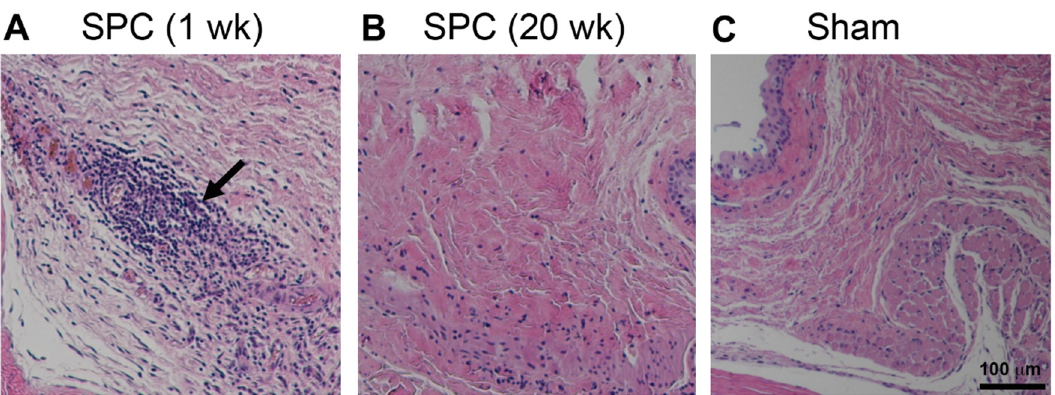
Figure 3. SPC microcrystals were well-tolerated in the subconjunctival space in rats. Either SPC microcrystals (200 μ g in 5 μ L) or vehicle (Sham) were injected unilaterally ( n = 3). Representative hematoxylin and eosin-stained images of conjunctiva tissue sections showed ( A ) mild accumulation of inflammatory cells at the injection site at 1 week after SPC microcrystal injection, which ( B ) was largely resolved before 20 weeks, similar to ( C ) vehicle injection at 1 week. Scale bar = 100 μ m and applies to all images.